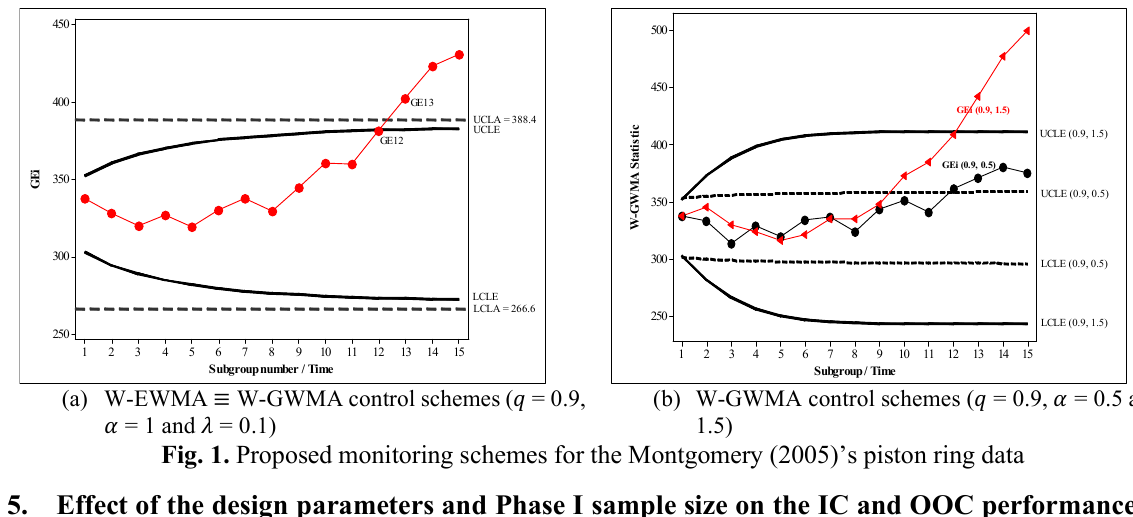
Fig. 1. Proposed monitoring schemes for the Montgomery (2005)’s piston ring